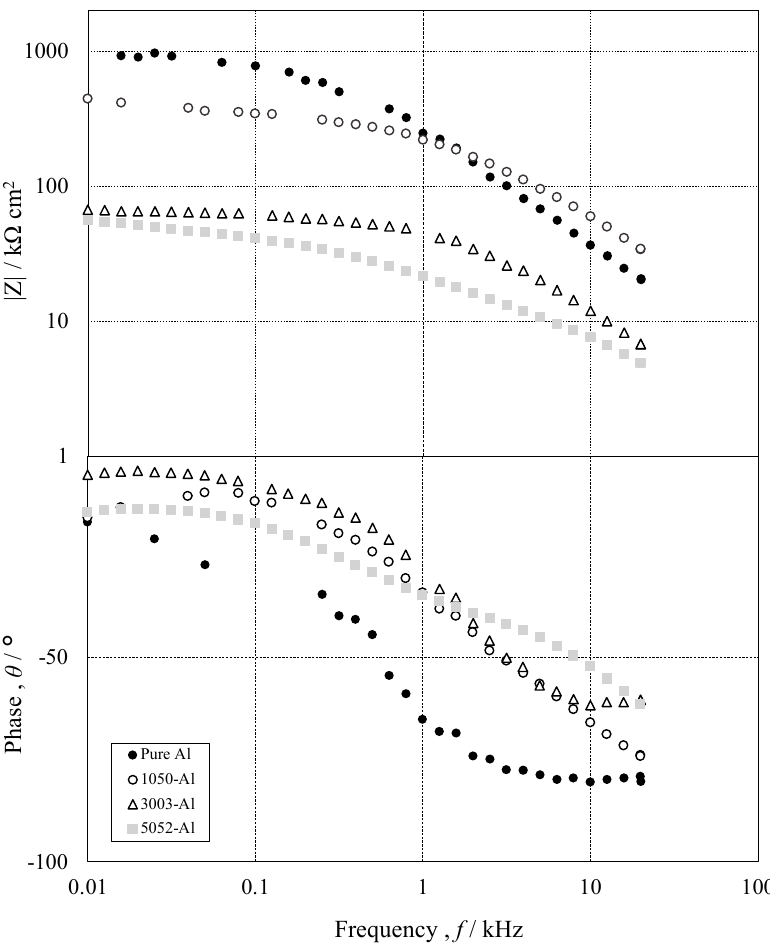
Figure 11. Bode plot on pure Al ( • ), 1050- ( ), 3003- ( (cid:52) ) and 5052- ( (cid:3) ) Al alloys with t a = 3600 s and (cid:35) t s = 1200 s, obtained by EIS measurements. EIS measurements were carried out in 2.0 kmol m − 3 -NaCl solution after bubbling N 2 gas for 1200